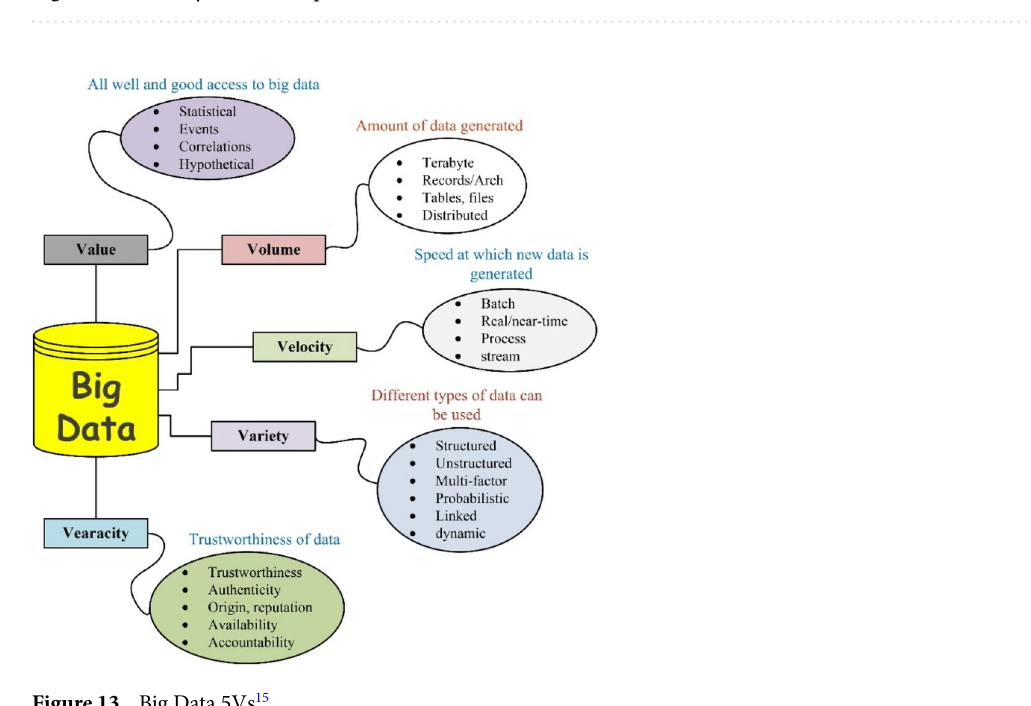
Figure 12. Quality assessment process.